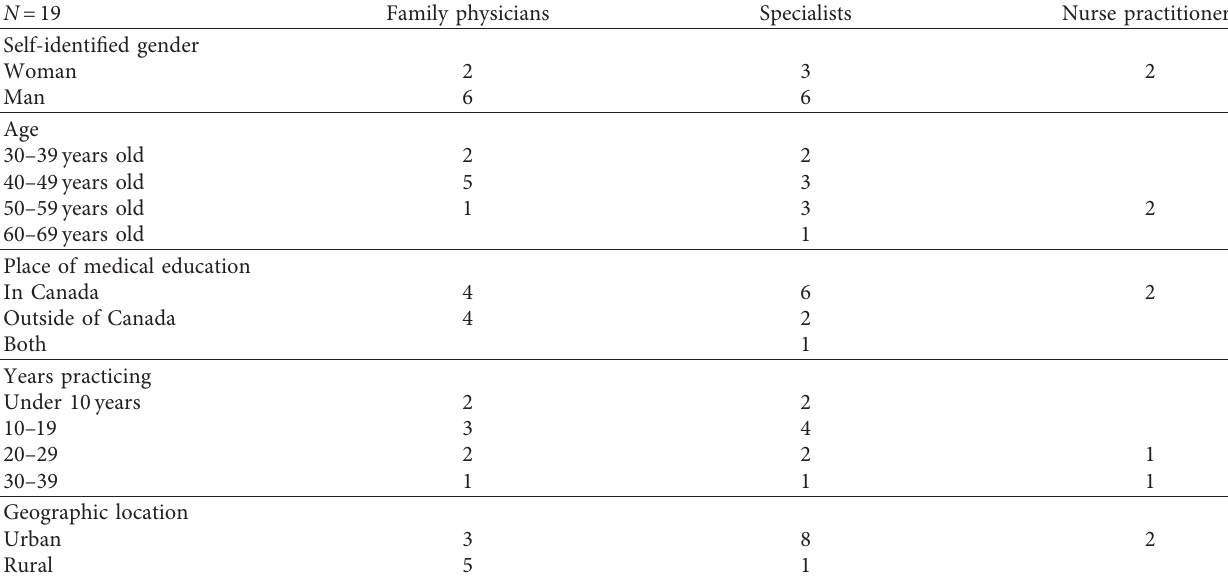
Table 1: Participant